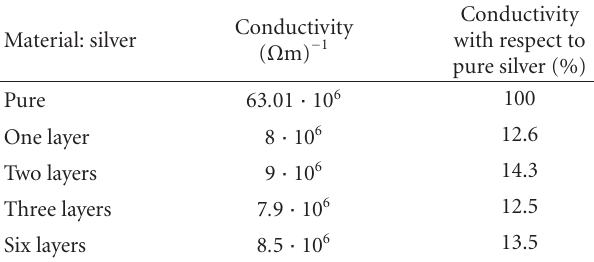
Table 1: Obtained conductivity values with 30min@200 ◦ C sinter- ing process.